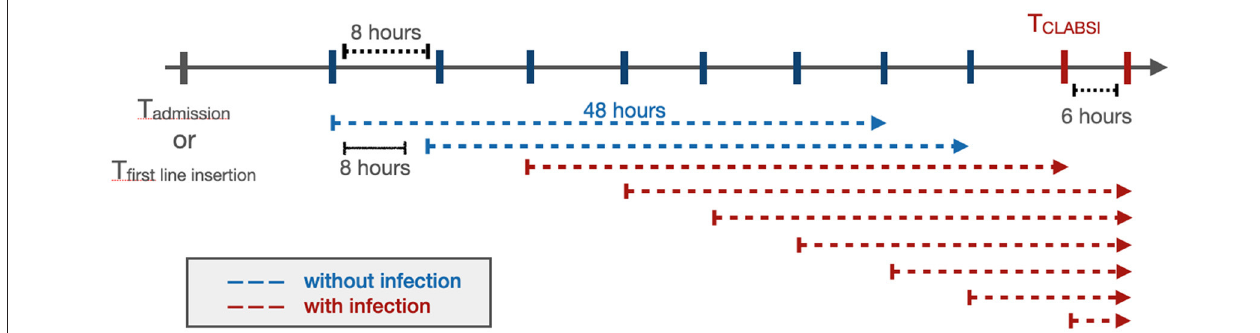
FIGURE 1 | The window-wise study design. If a patient had a documented CVL that was not documented as removed at the time of admission, the start point of the analysis would be the admission time. Otherwise, the start point would be the first line insertion time. The prediction window was 48h with an 8h sliding window until the end of the patient’s hospitalization or removal of the last CVL. When the onset of CLABSI occurred within a 48h prediction window, that window was considered positive (red), while the rest (blue) were labeled as negative. The prediction was performed at the start of each arrow.